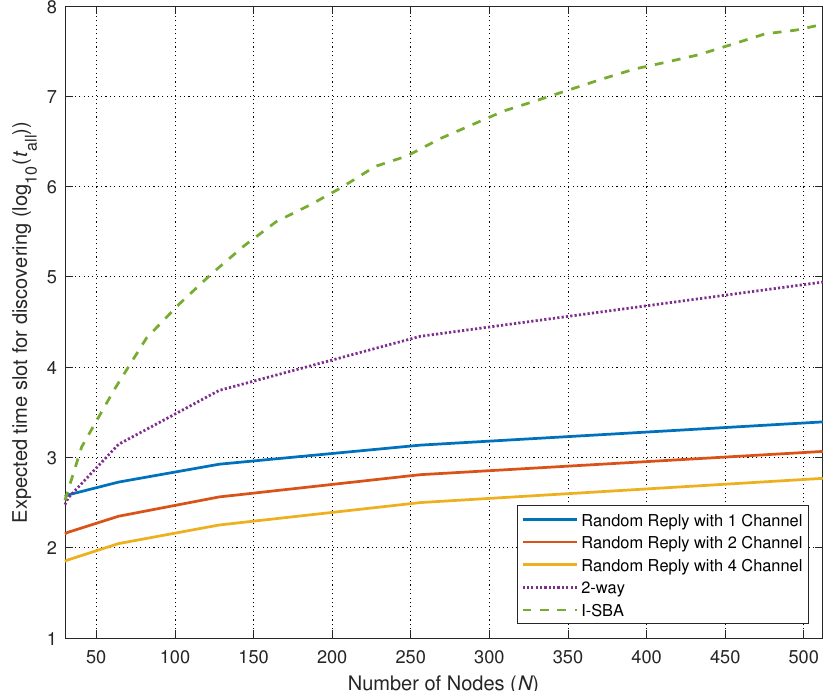
Figure 11. Comparison between neighbor discovery algorithm with random reply ( K =